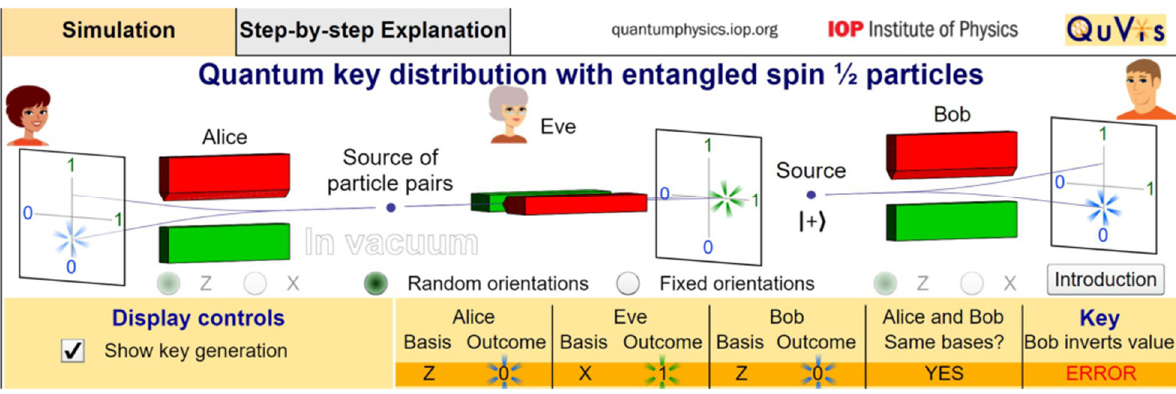
Figure 5. Third lecture: QuVis simulation of BBM92 cryptographic protocol in the presence of an eavesdropper. Alice and Bob share a source of entangled spin-1/2 particles and measure through Z-magnet or X-magnet to obtain a secret key. The eavesdropper Eve measures the spin state of the transiting qubit toward Bob. Eve cannot measure simultaneously along Z and X and therefore cannot obtain complete information about the spin state of the intercepted qubit. When Eve resends the qubit to Bob the spin can be different from the original one; for details, see [23].